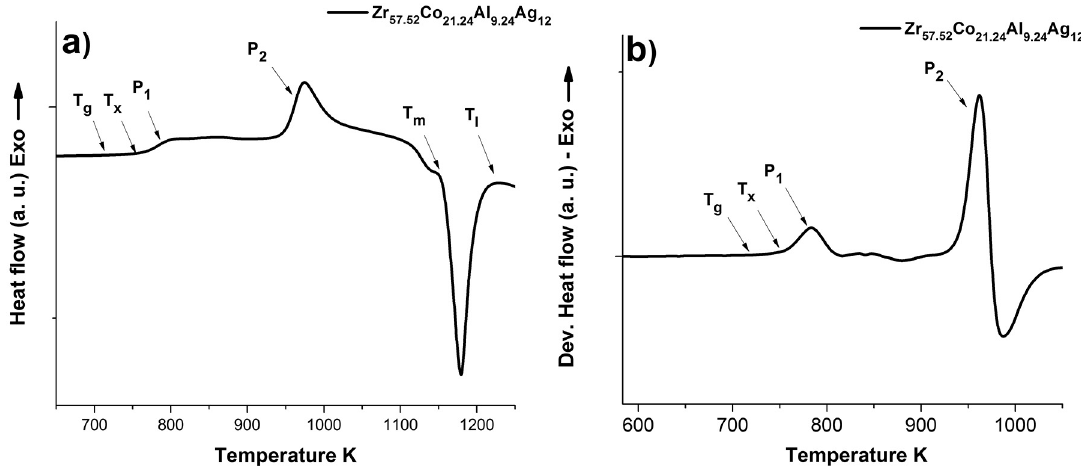
= 2 mm, at heating rate of 0.67 K s -1 . c